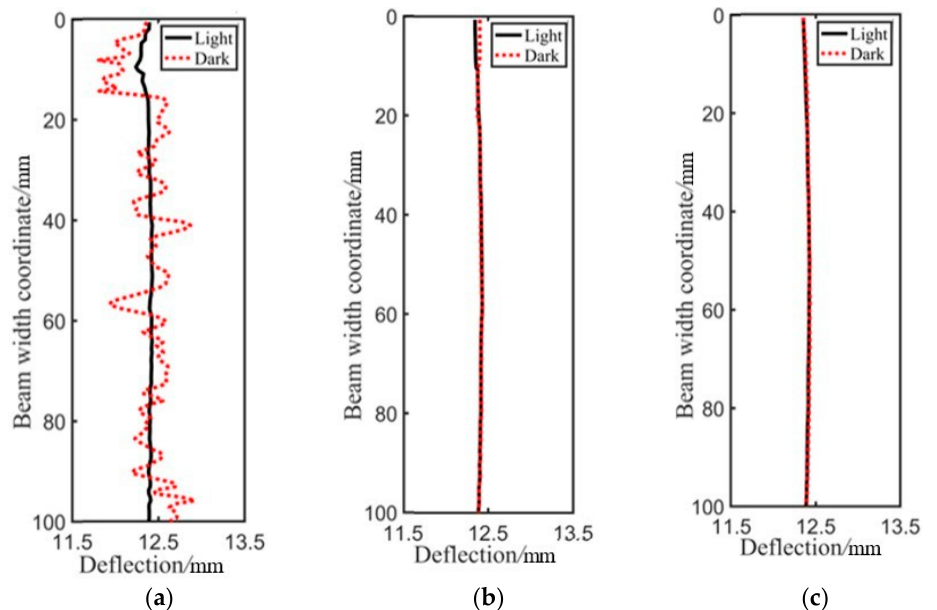
Figure 14. Identification results with different lighting conditions at micrometer 2: ( a ) GB; ( b ) DPG; ( c ) N–R.